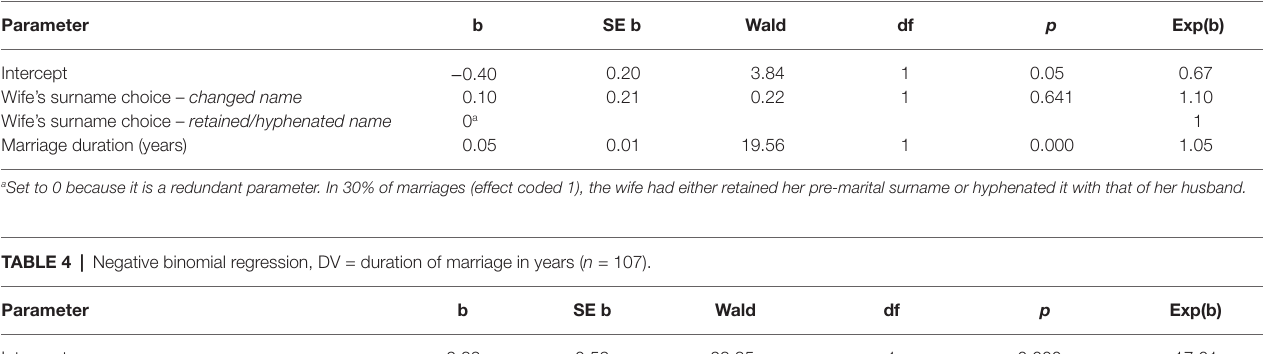
TABLE 3 | Poisson regression, DV = number of children of the marriage ( n = 107). Parameter b SE b Wald